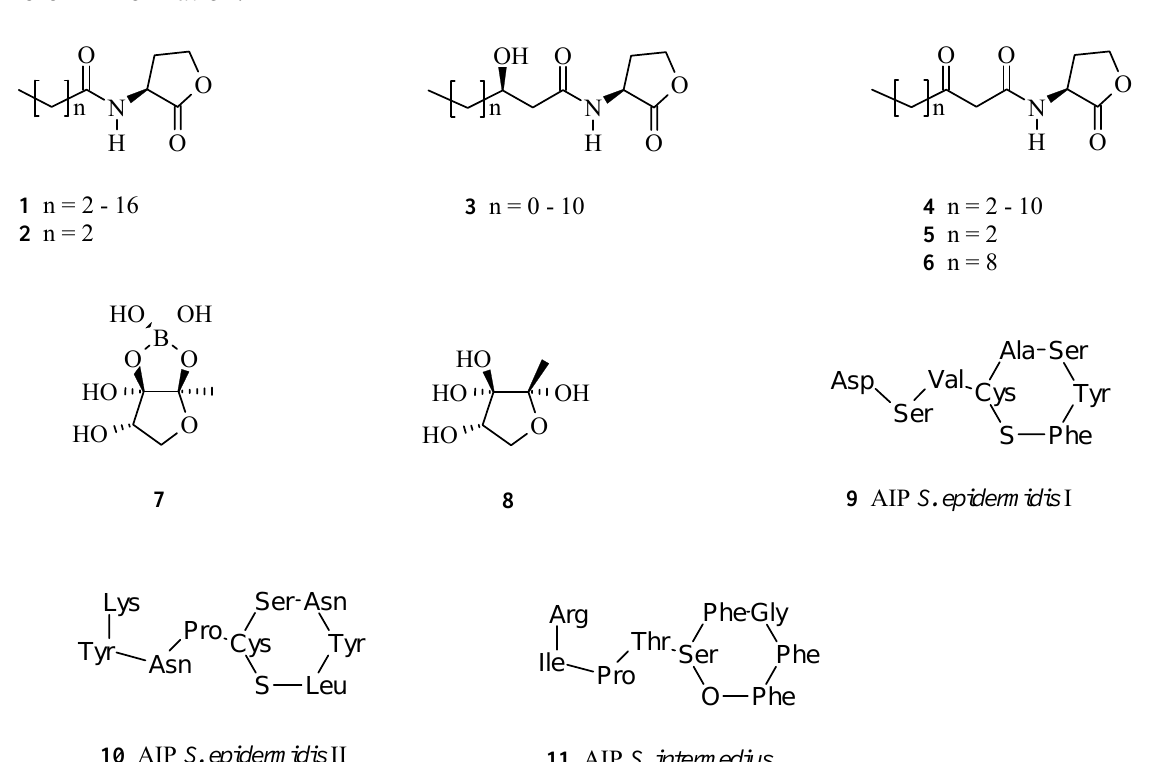
Figure 1. Small compounds, called autoinducers, used for quorum sensing and inducing biofilm